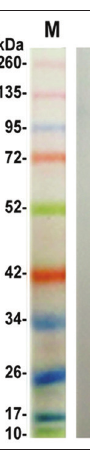
Figure-3: Immunogenic reactivity profile of excretory- secretory Cyathostomins spp . antigen (Lane 1), excretory- secretory Strongylus vulgaris antigen (Lane 2), crude somatic Cyathostomins spp antigen (Lane 3), crude somatic S. vulgaris antigen (Lane 4) against control negative sera and pre-stained molecular weight protein ladder, Fermentas (Lane M, 10-260